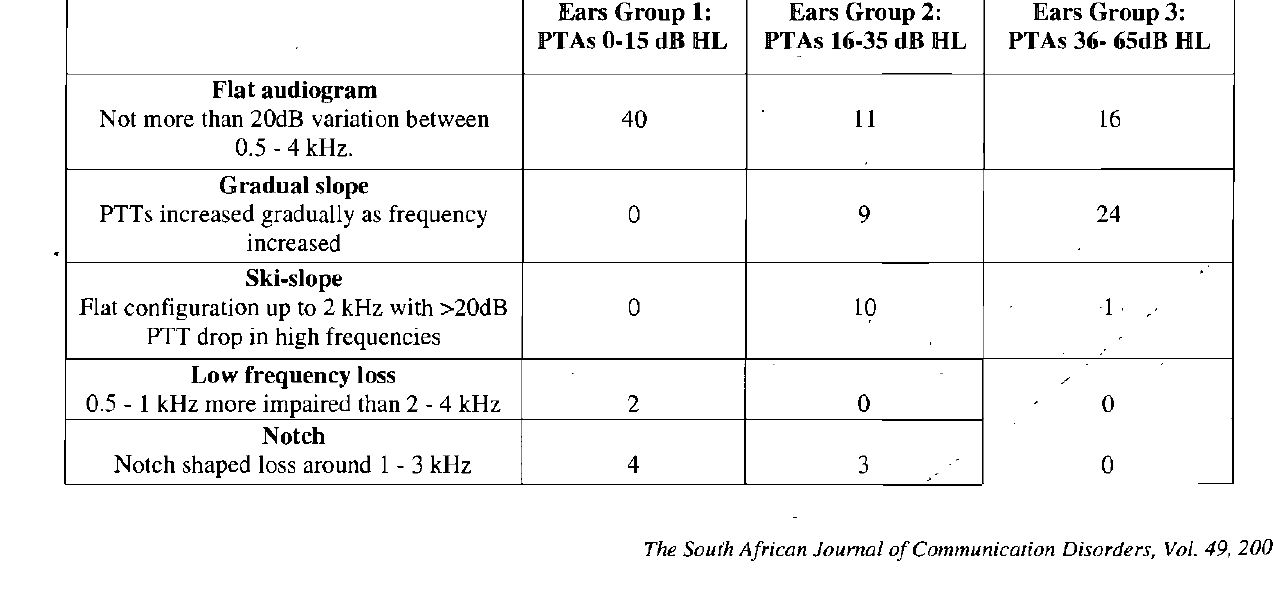
Table 1: Distribution pattern for different types of hearing loss in the 120 ear data set. Ears Group